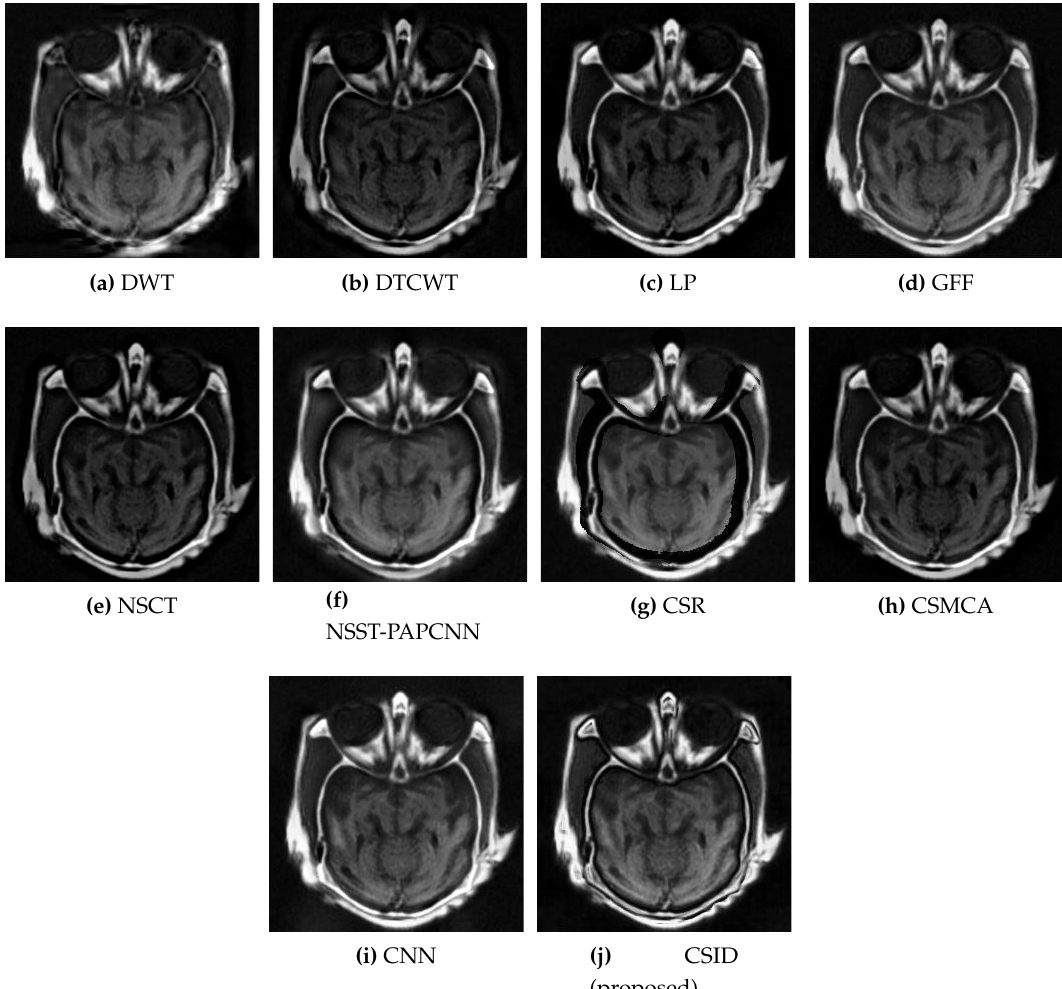
Figure 5. Comparative analysis, based upon visual observation, of the resultant fused images generated by the given set of algorithms using Data-1